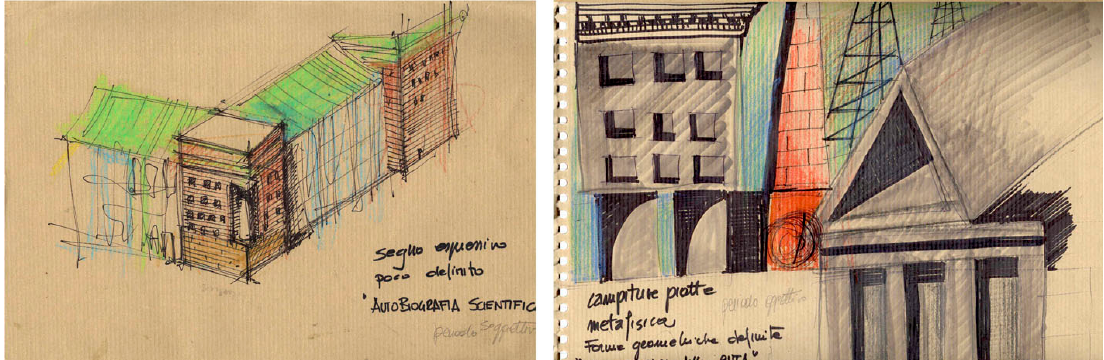
Figure 4. Giulia Bertola, interpretative sketches of Aldo Rossi’s